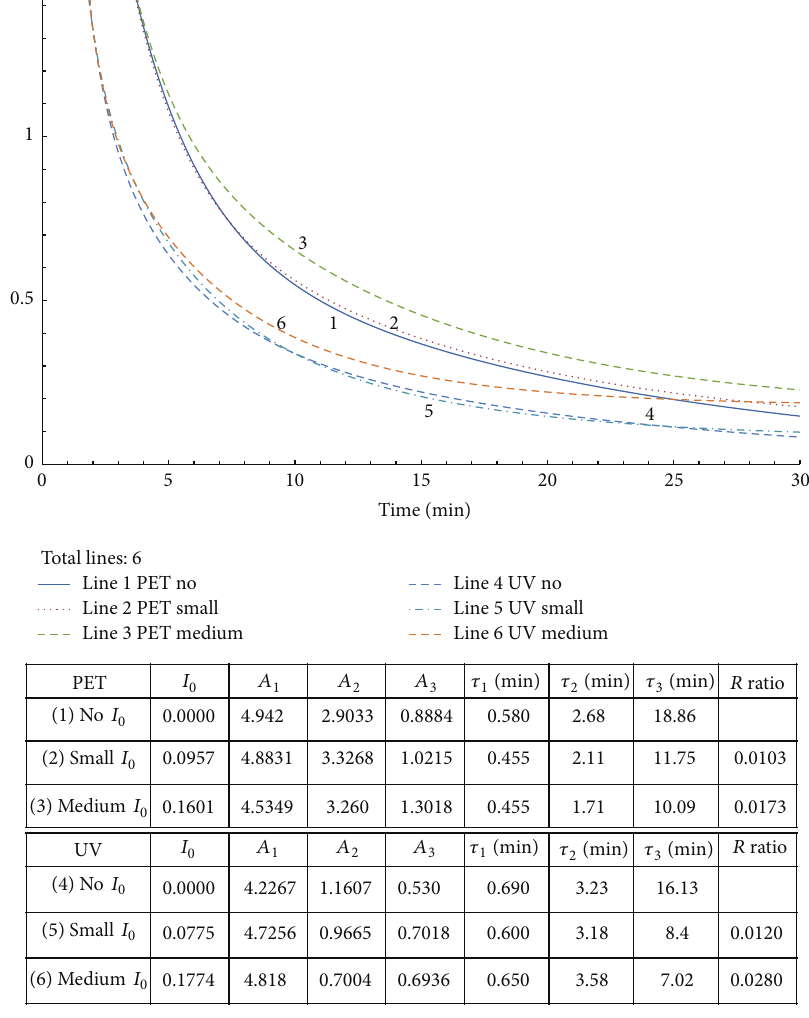
Figure 1: Decay curves used in this study as defined in Table 1. Table 2: Simulated by using equations with the 𝐼 0